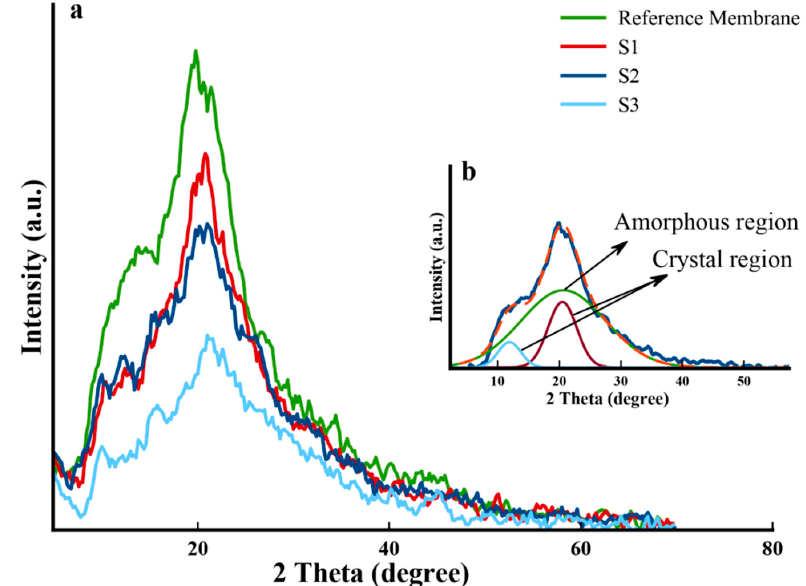
Figure 1. ( a ) XRD patterns of the reference membrane and the irradiated membrane. ( b ) Deconvolution of the XRD pattern of the reference sample.